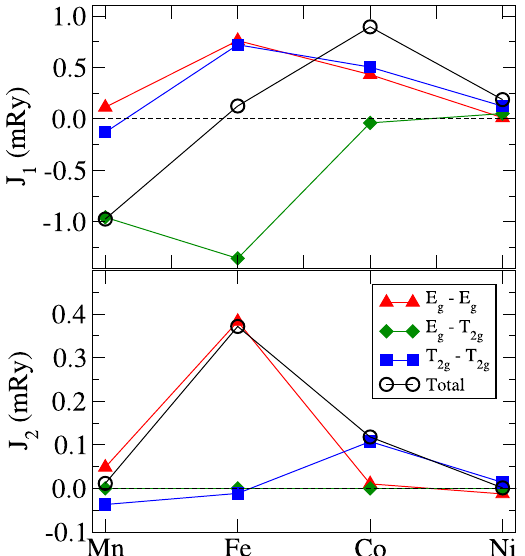
Figure 3. Orbitally-decomposed exchange interactions in elemental 3 d metals in the fcc structure. The results for high-spin solution in case of Fe are